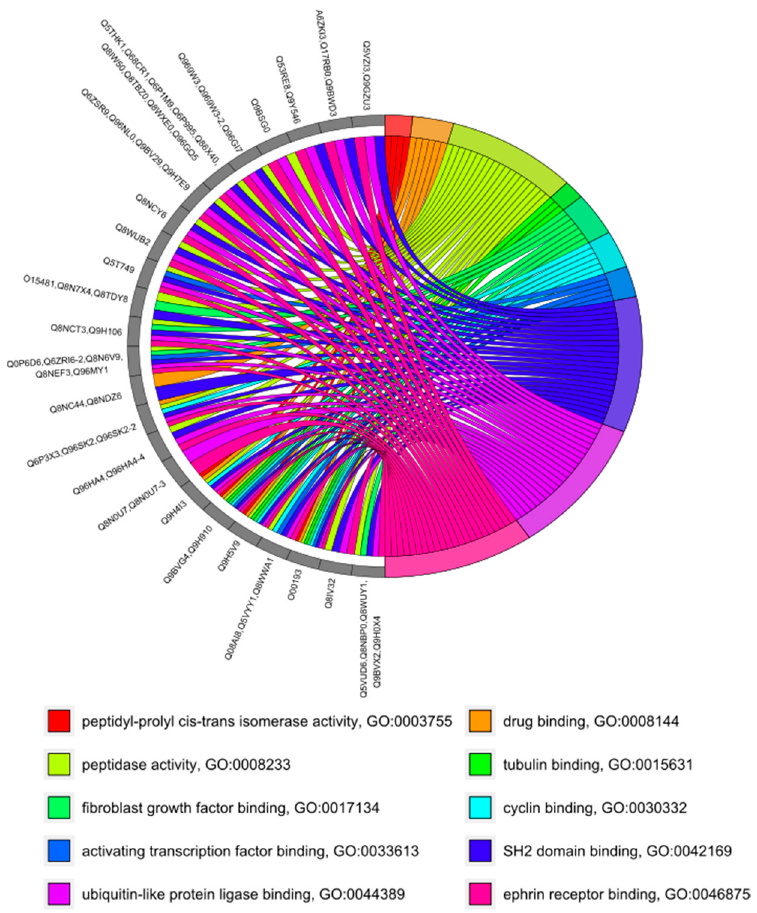
Figure 3. Functional prediction of molecular functions for 60 uPE1 proteins.